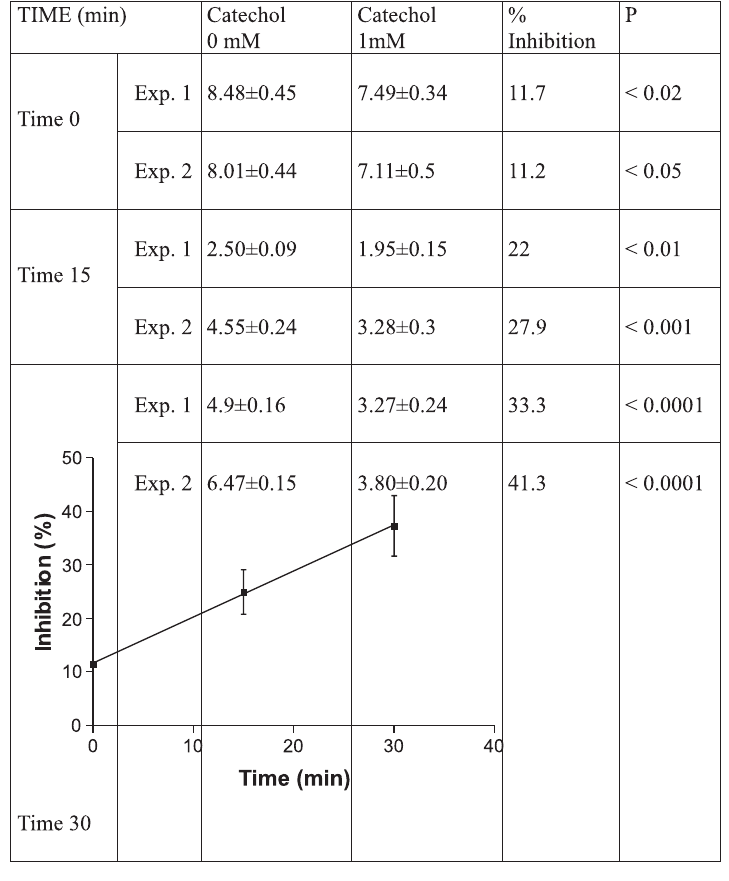
Table 1. Inhibition of liver mitochondrial state 2 FADH -linked respiration by 1 mM catechol. Liver homogenates were incubated 2 in the absence (controls) or in the presence of 1 mM catechol for times ranging between 0 - 30 minutes prior to mitochondrial isolation. Two independent experiments were carried out for each incubation. Four assays of oxygen uptake were analyzed in each experiment. Data are expressed as mean ± SD.